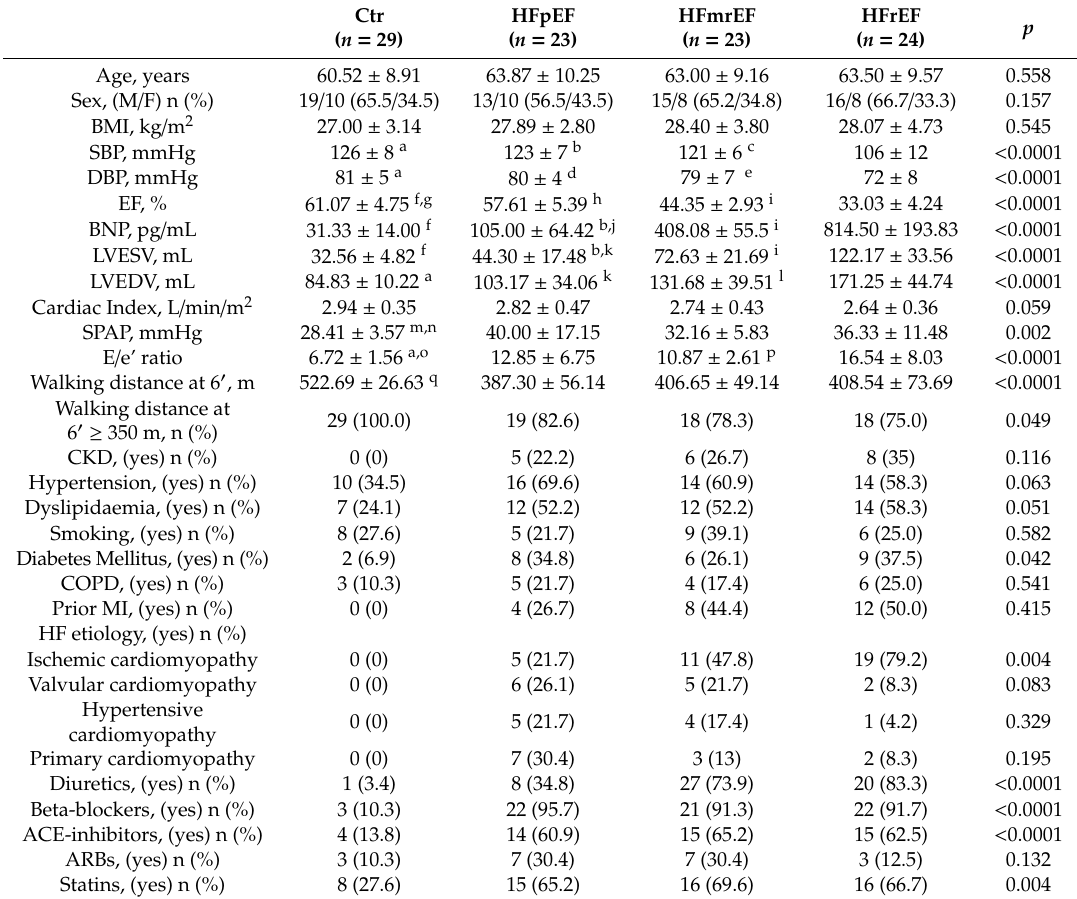
Table 1. Main characteristics of the study population stratified by No HF Controls and on the basis of HF